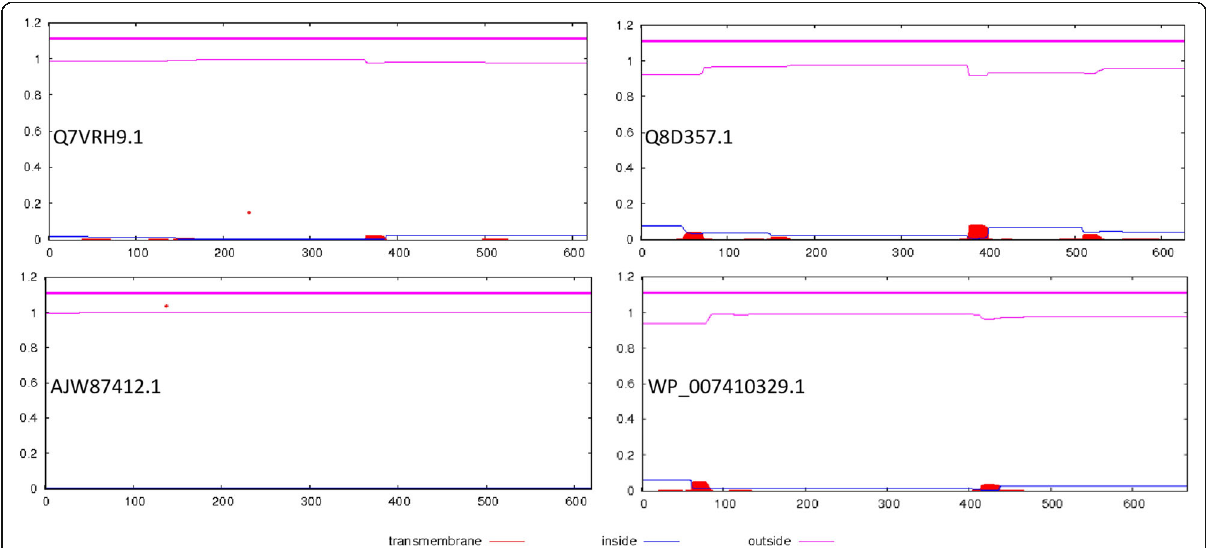
Fig. 6 Prediction of protein transmembrane structure for representative sequences Q7VRH9.1, and Q8D357.1, and AJW87412.1 and